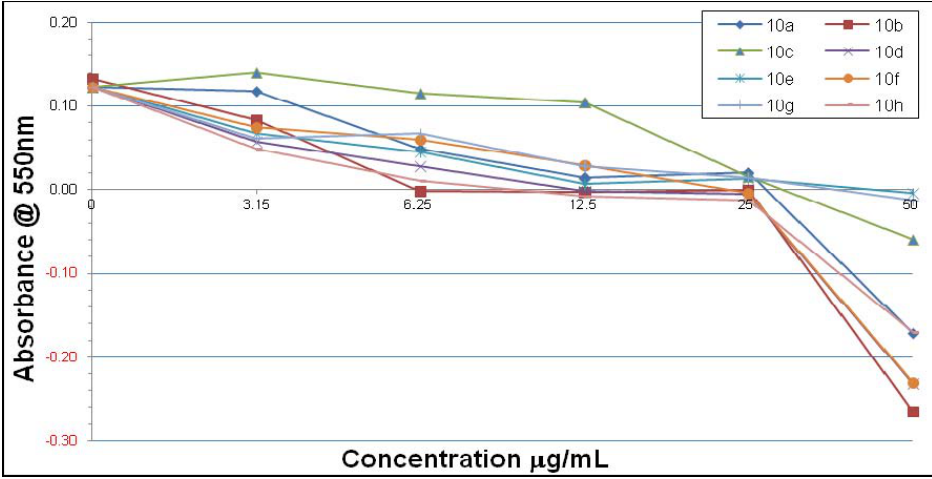
Figure 1. Inhibitory effects of compounds 10a – h on H. pylori 3339 after 7 days.